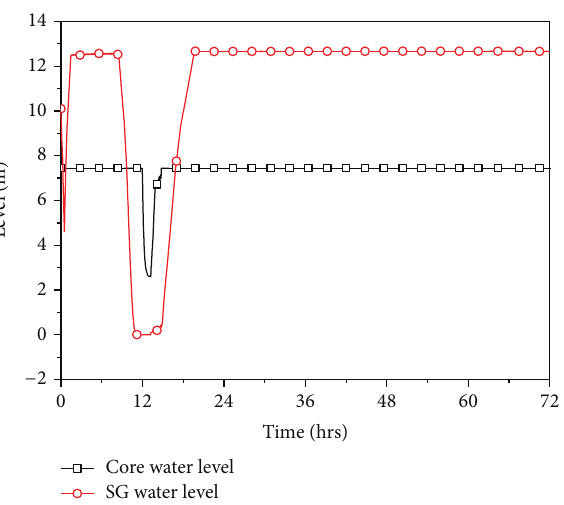
Figure 8: Secondary injection RCS and SG water level.